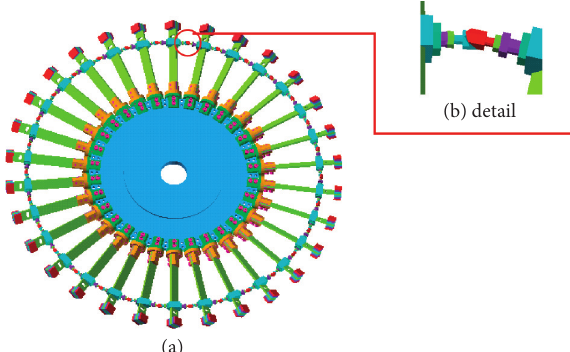
Figure 1: Bladed wheel model with interblade tie-boss couplings. Figure 1 is reproduced from